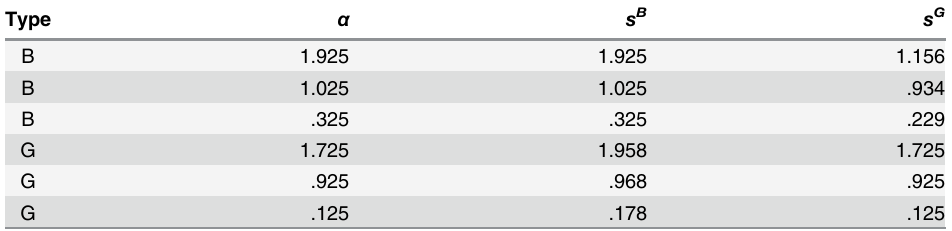
Table 1. Reputation in a mixed group. Equilibrium reputations, s B and s G , calculated for a mixed group of 40 players of varying ability ( α ). A random 20 players follow norm B and 20 follow G; results are given for three representative players of each type. Players accurately assess abilities of those of their own type, but under- or overestimate abilities of those of unlike type.)